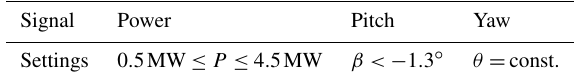
Table 1. Filters applied to the raw data of each wind turbine within the wind farm. Signal Power Pitch Yaw Settings 0 . 5MW ≤ P ≤ 4 . 5MW β < − 1 . 3 ◦ θ =